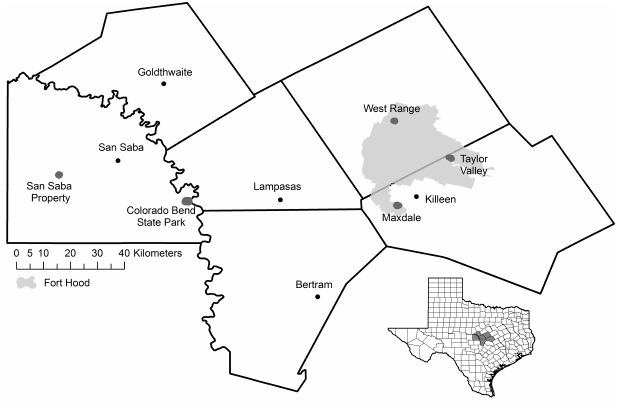
Fig. 1 . Study site locations for Black-capped Vireo nest recordings in central Texas,